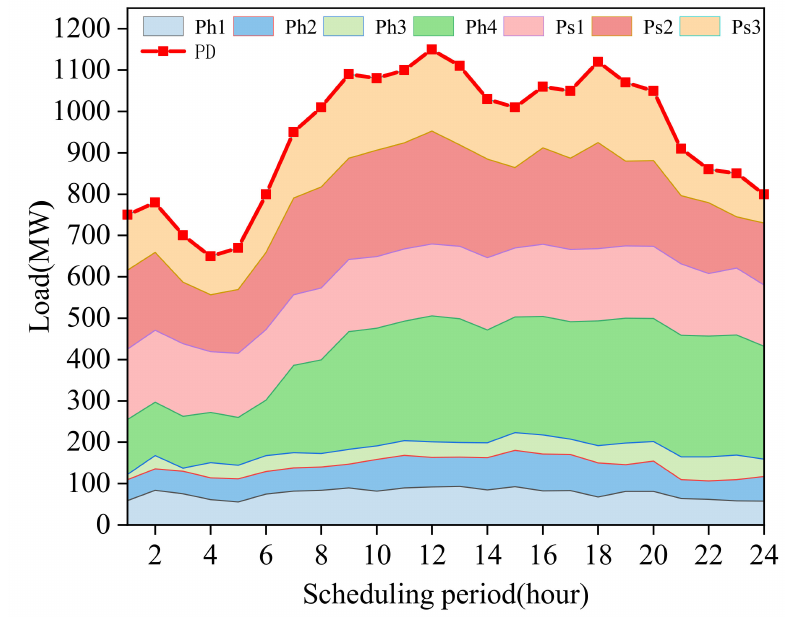
Figure 7. Output superposition diagram of hydropower station. Table 13. Scheduling process of hydropower station (unit: 10,000 m 3